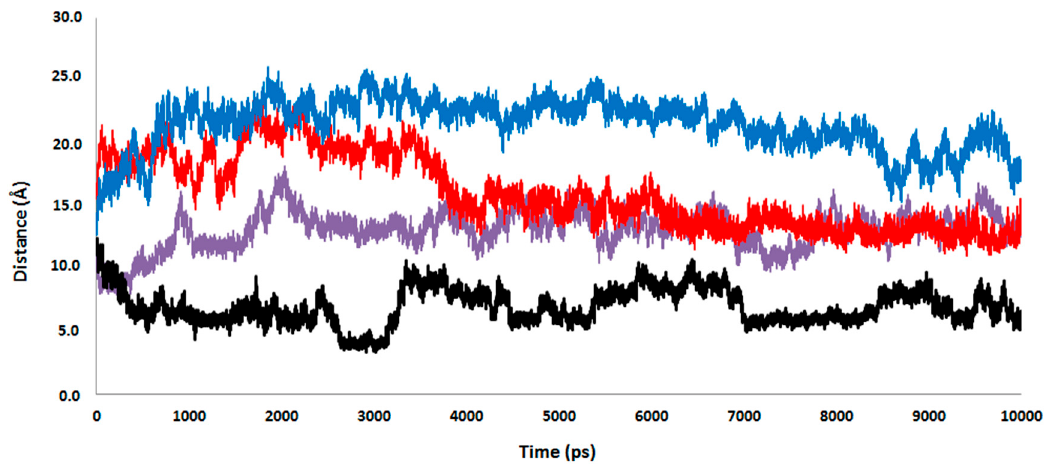
Figure 6. Time evolution of the distances between the closest atom of poly-P and the magnesium atoms in the wild-type (purple line), the magnesium atoms in the 1H2 mutant (black line), the residue 526 in the wild-type (red line), and the residue 526 in the 1H2 mutant (blue line). Results obtained from the 10 ns MD simulation.